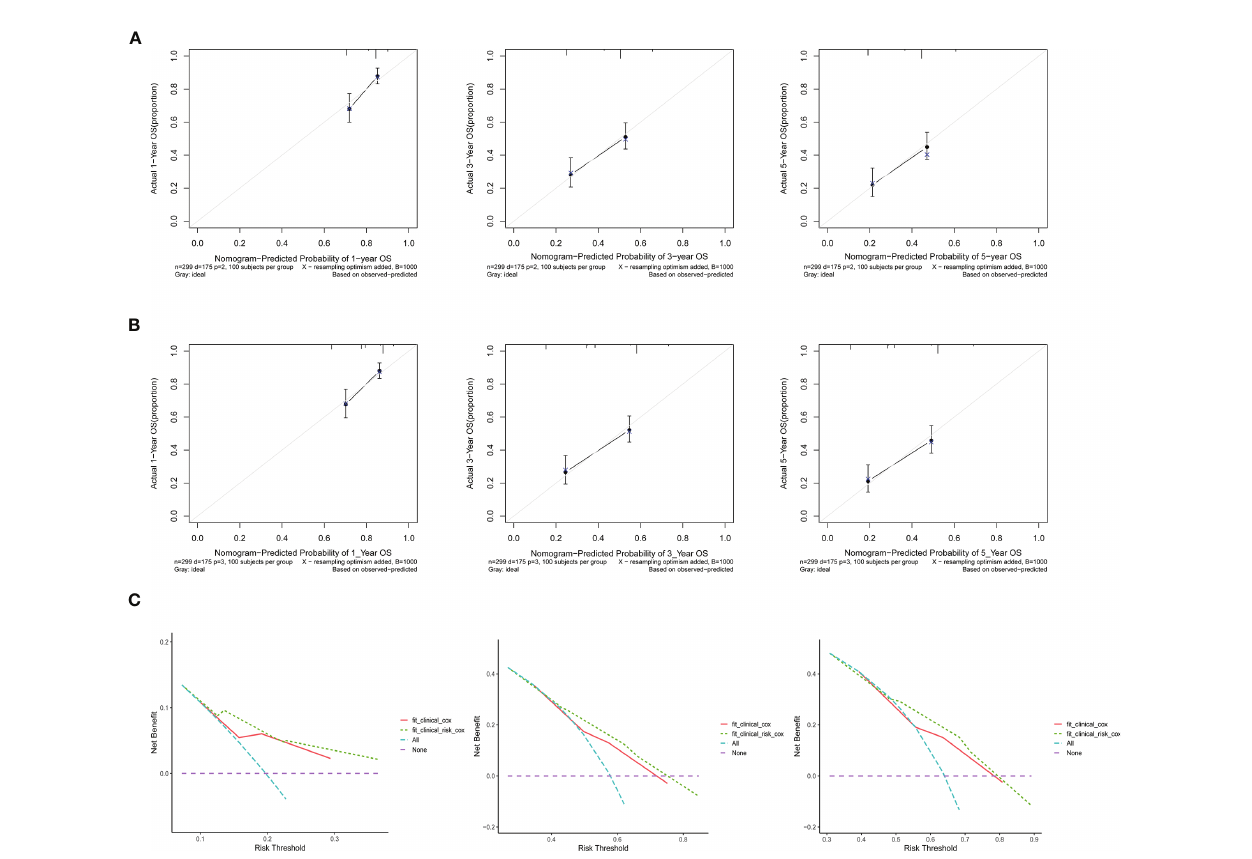
FIGURE 5 | Calibration curves revealed the prediction effects of the nomogram graphs using (A) clinical variables and (B) Risk and clinical variables. (C) Decision curve analyses showed the net clinical bene fi ts of the two